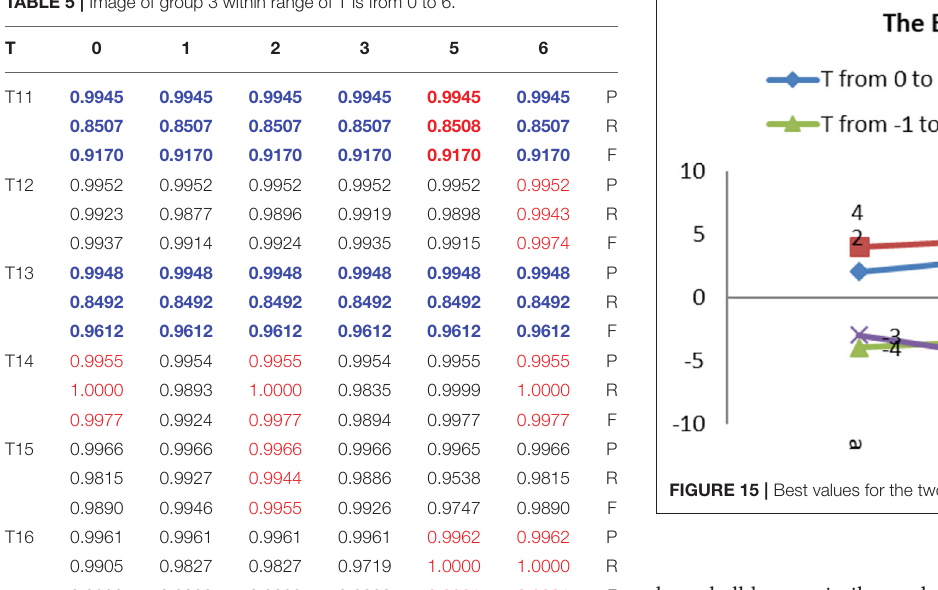
TABLE 5 | Image of group 3 within range of T is from 0 to 6.